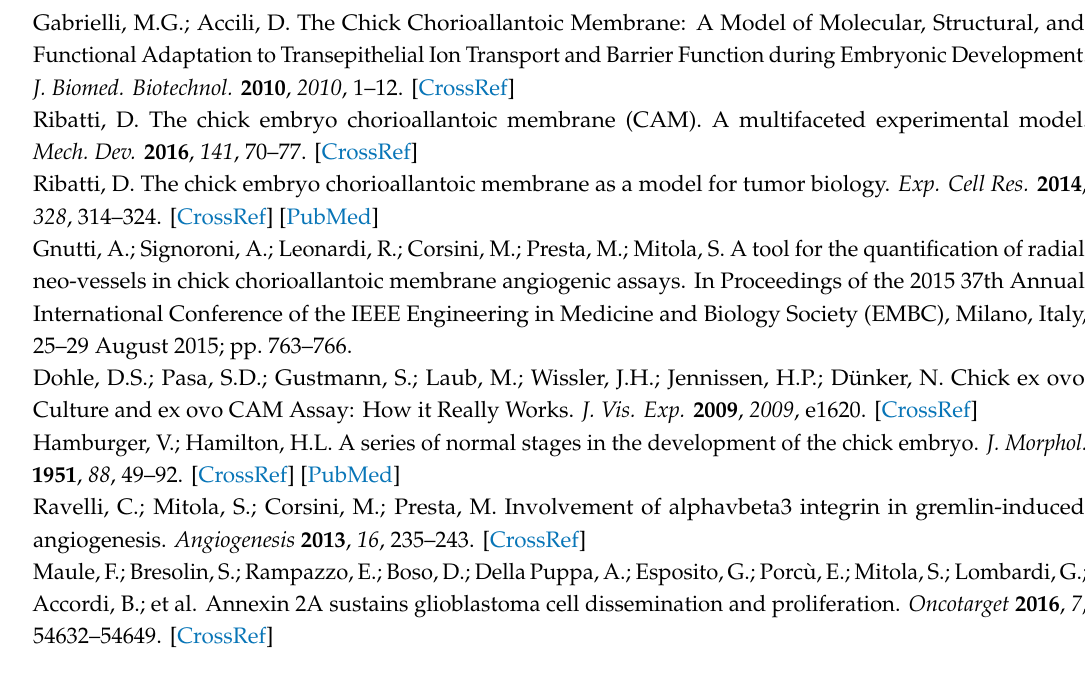
Figure 4. In situ DNA/CREB interaction on murine endothelial cells. Endothelial cells stimulated with murine recombinant gremlin for 0, 10, 20, 60 min, washed and subjected to in situ DNA/CREB–interaction assay. Images were acquired using a Zeiss Axio Imager.A2 microscope equipped with 20× EC Plan-NEOFLUAR objective.